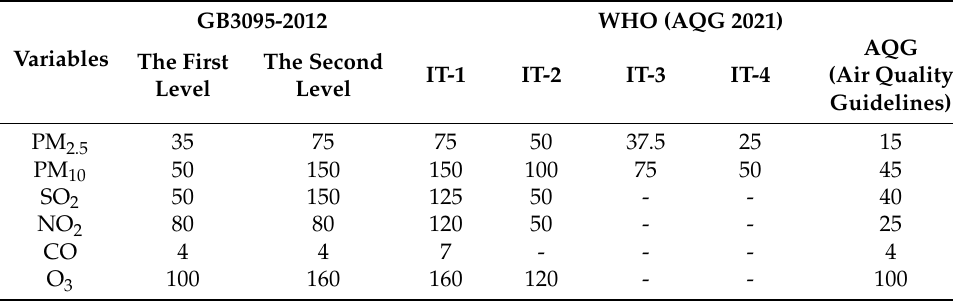
Figure A1. Spatial distribution of sample monitoring points. Table A1. Air pollution concentration limit of GB3095-2012 and WHO (AQG 2021).